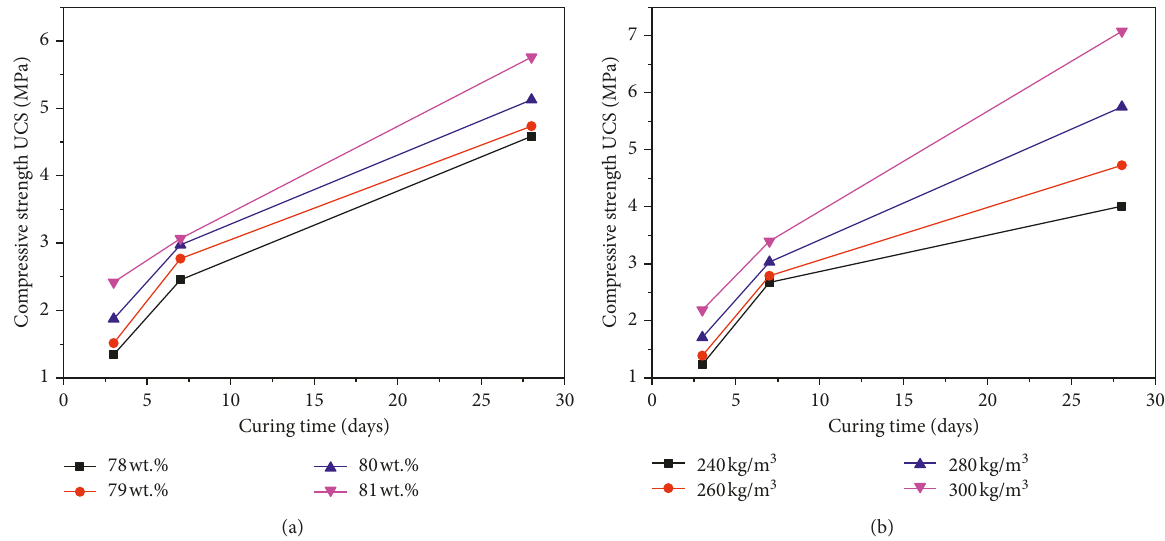
Figure 7: The relationship between uniaxial compressive strength and curing time. (a) Cement content was 260kg/m 3 and the tailings-waste ratio was 4 :6. (b) Concentration 79wt.% and the tailings-waste ratio was 3: